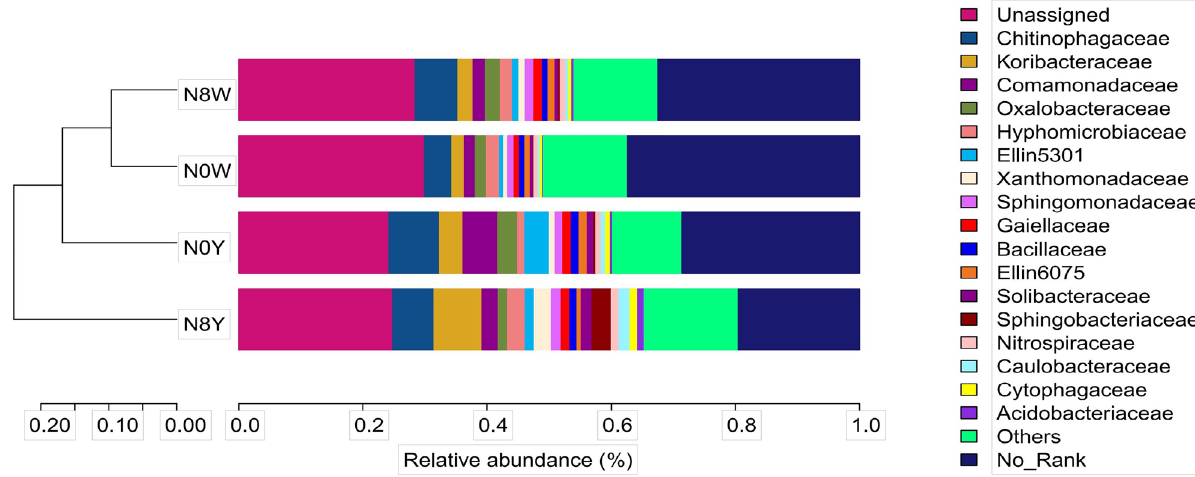
Figure 2. Analysis of relative abundance of soil microorganisms between sorghum roots under different nitrogen